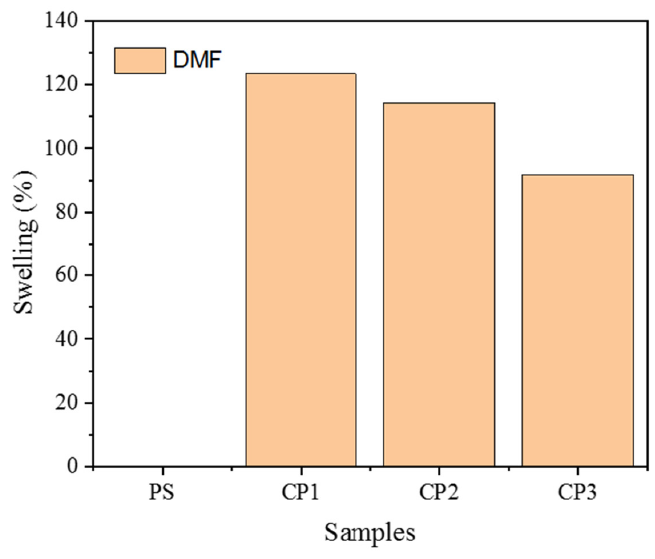
Figure 6. Dynamic mechanical analysis (DMA) curves for copolymers: ( a ) Storage modulus of copolymers; ( b ) Tan delta of copolymers.